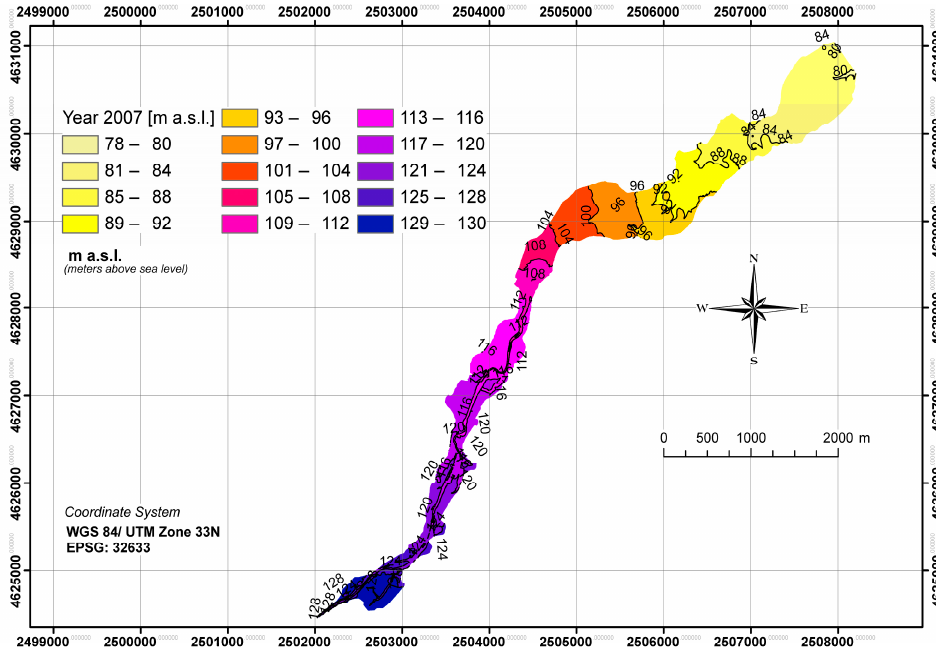
Figure 7. Contour lines in the fluvial reach immediately upstream of the Di Blasi bridge (2007).